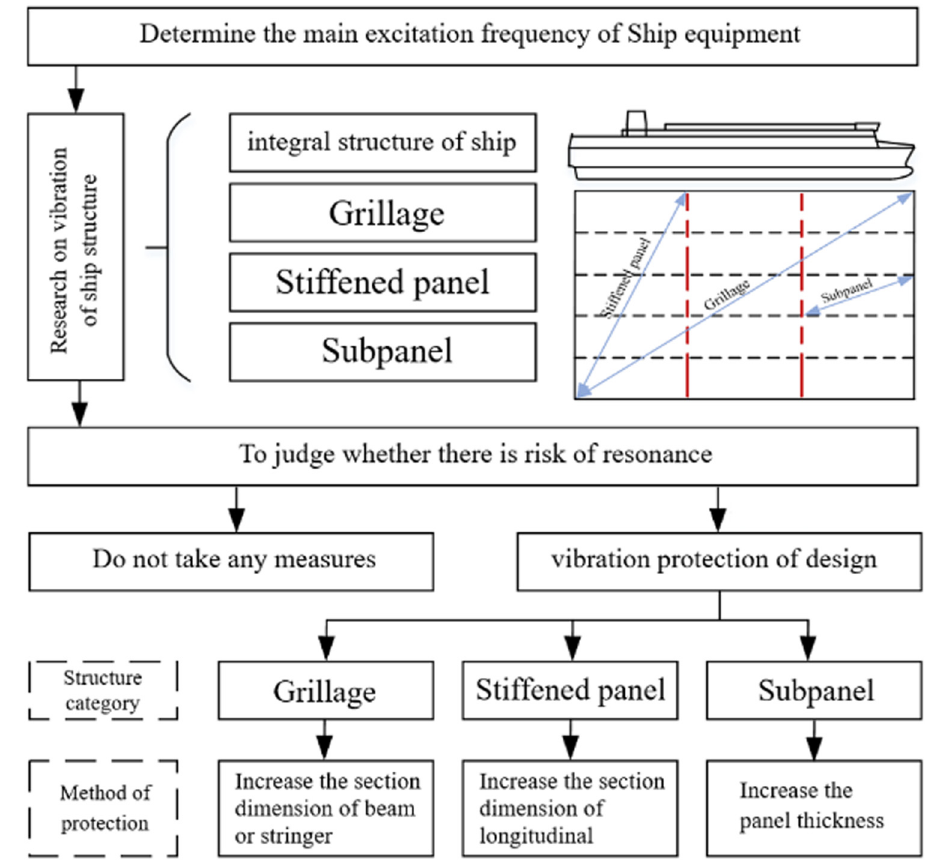
Figure 16: Flow chart of vibration protection of ship